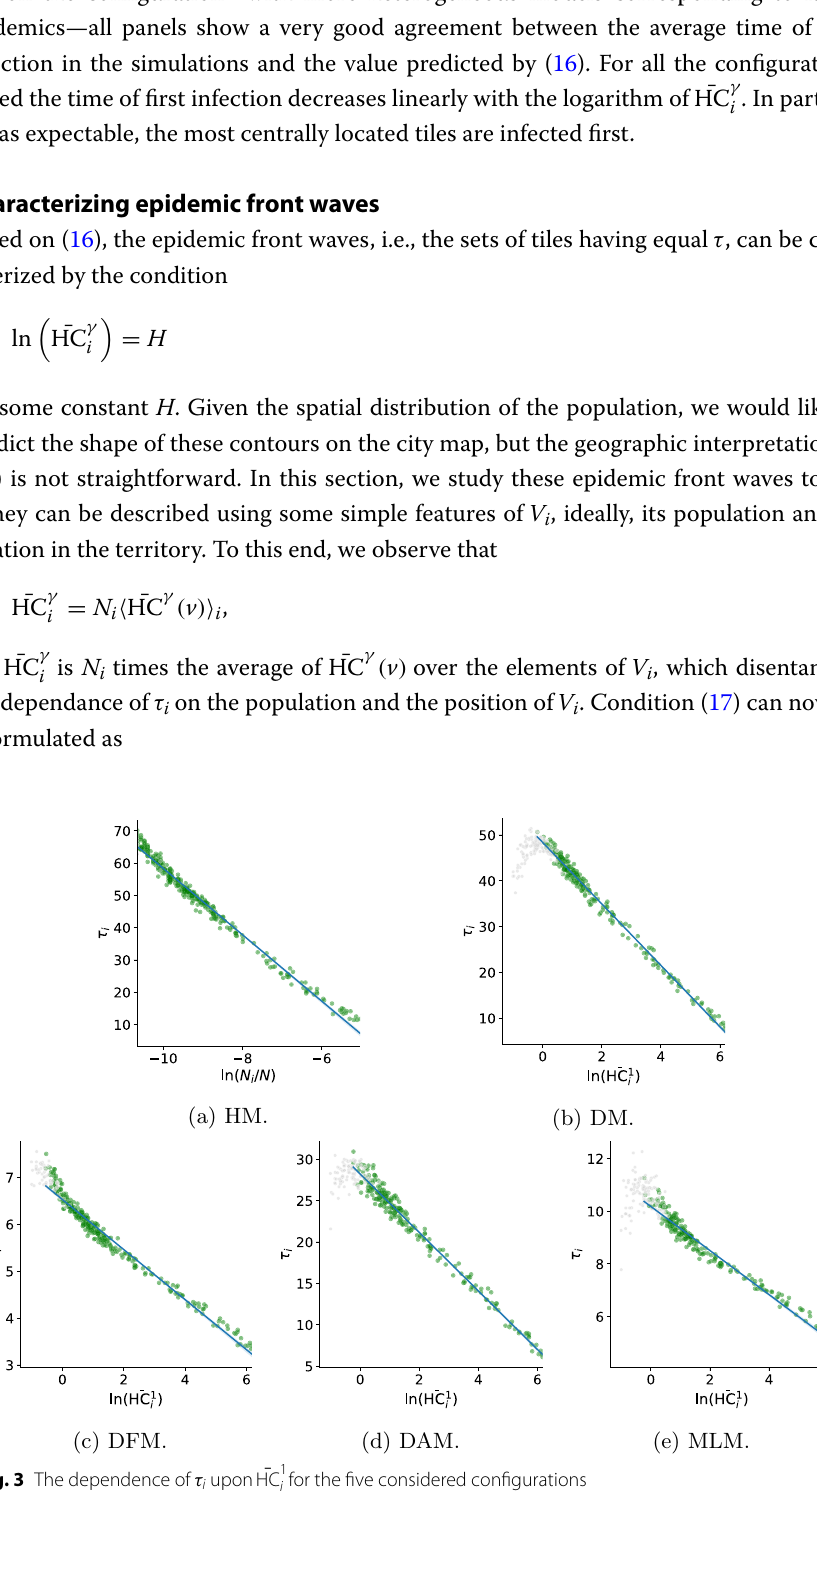
Fig. 3 The dependence of τ i upon ¯ HC